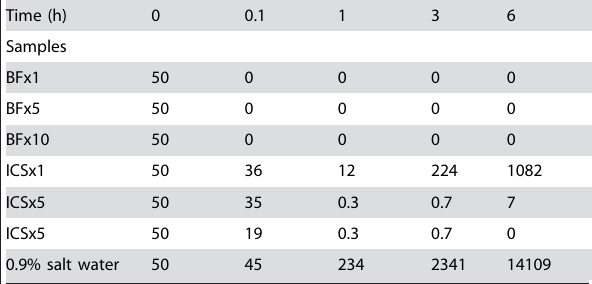
Table 3. Bacterial killing kinetics of cathelicidin-BF against E. coli .